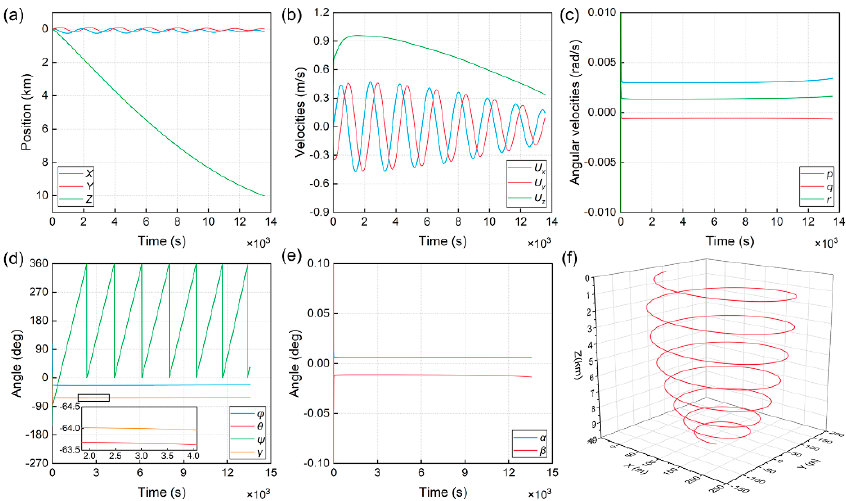
Figure 12. Spiral motion simulation in VM mode: ( a ) Position; ( b ) Velocities; ( c ) Angular velocities; ( d ) Euler angles and gliding angles; ( e ) Attack angle and side slip angle; ( f ) 3D trajectory.